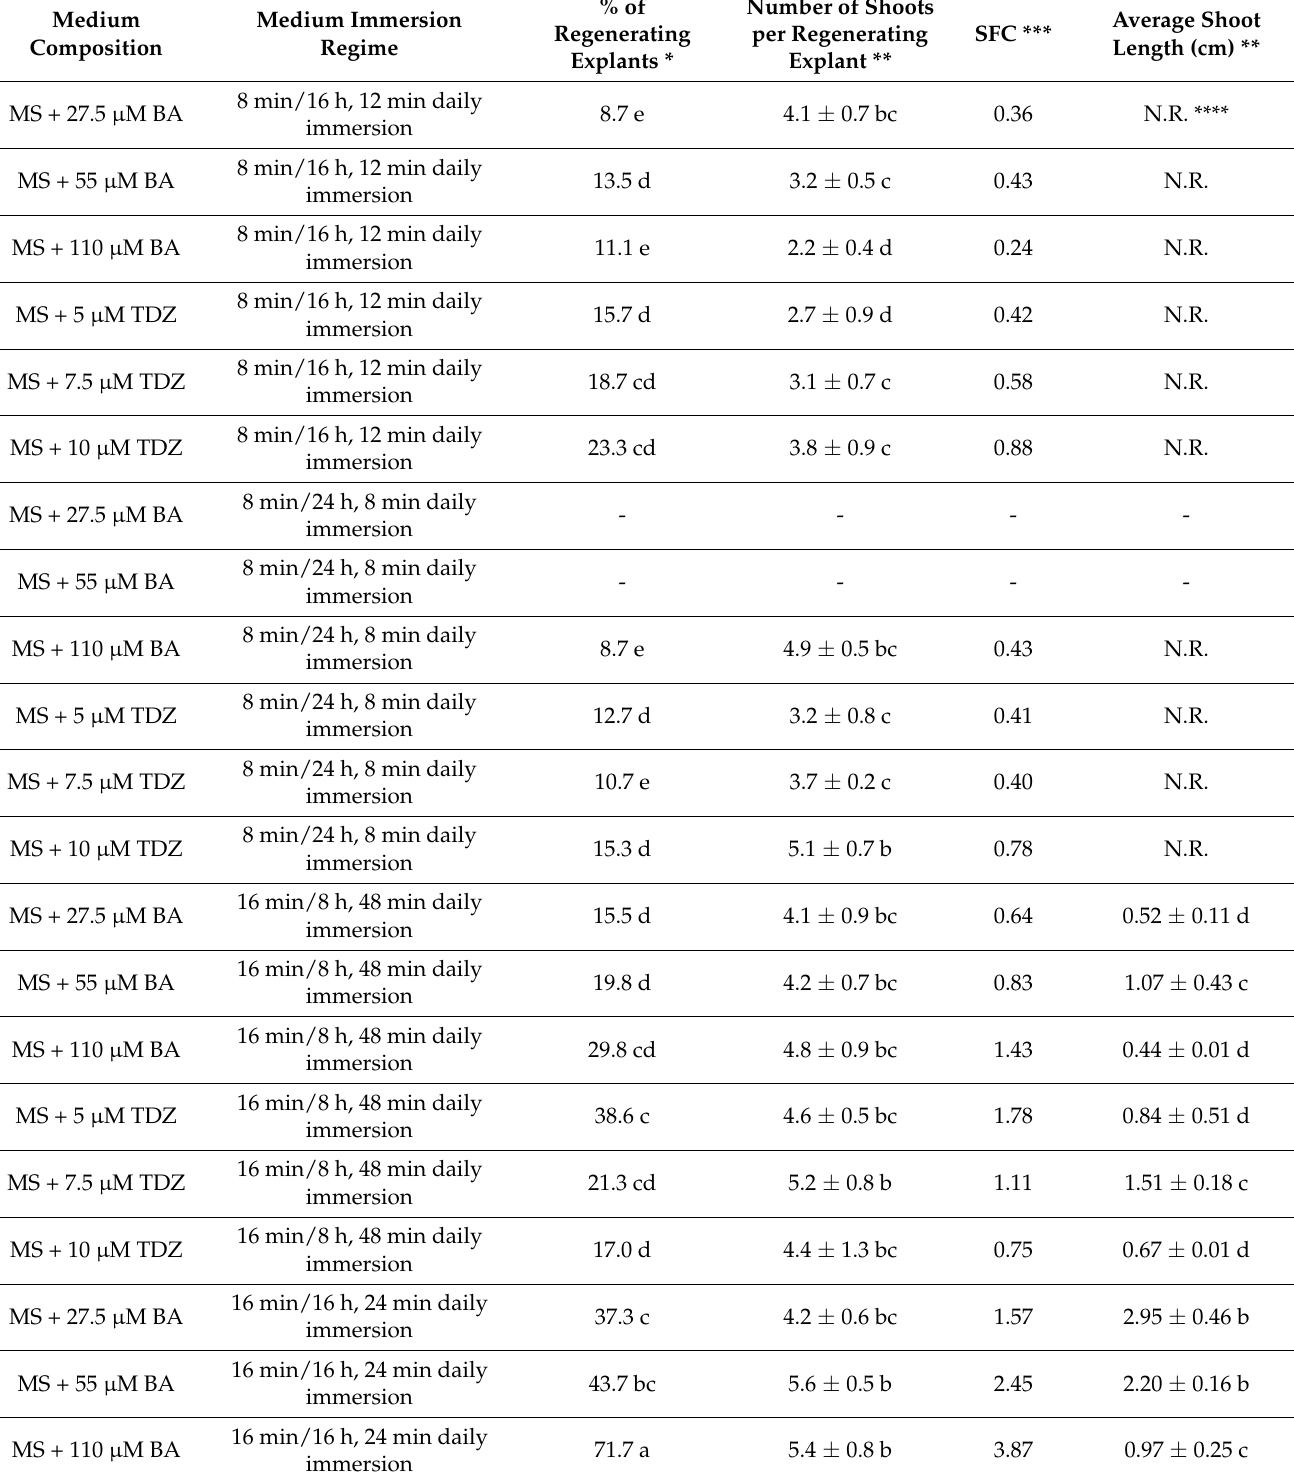
Table 4. De novo regeneration of Arachis hypogaea L. cv. Virginia shoots on de-embryonated cotyle- dons, when cultured in TIS, under the influence of different medium immersion